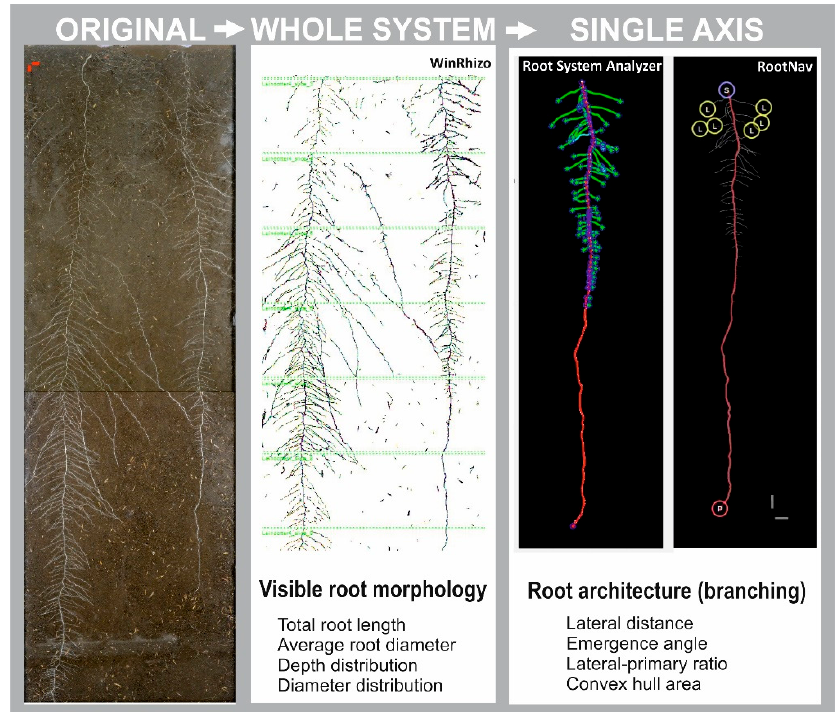
Figure 4. Image analysis procedure. Left: original RGB image; middle: color ‐ segmented image in WinRhizo subdivided into 10 cm depth segments (light ‐ green lines) for measurement of root morphological parameters; right: manually tracked single axis in Root System Analyzer and RootNav for measuring architectural (branching) traits.